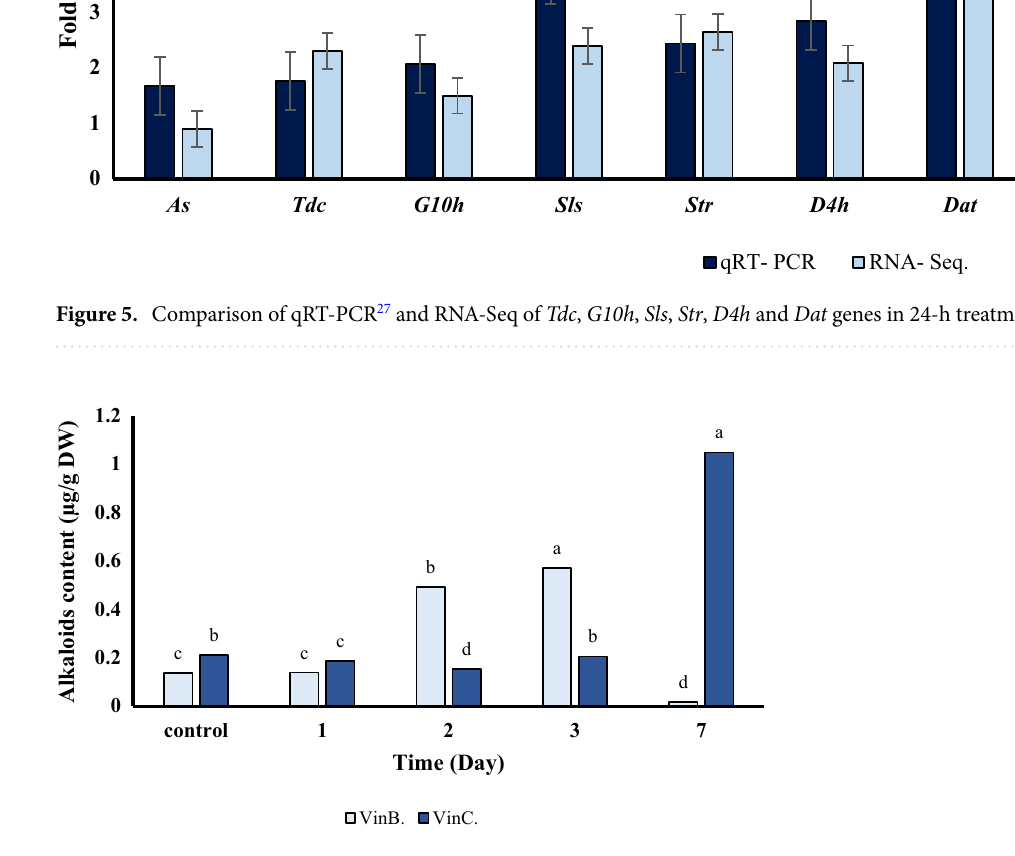
Figure 6. Effect of spraying of salicylic acid on vinblastine and vincristine content of C. roseus